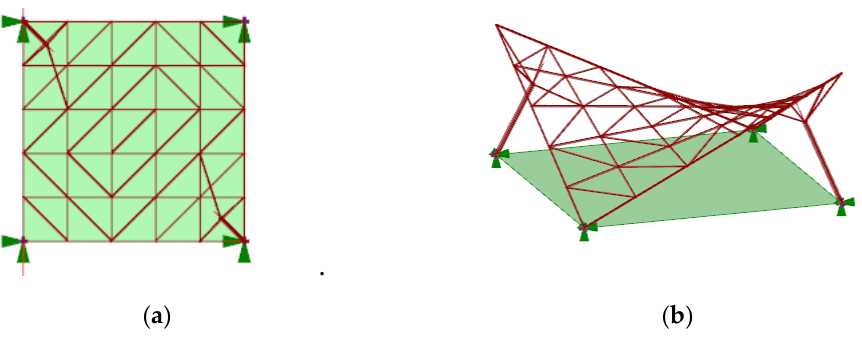
Figure 9. The structure of type a with the division of the grid pattern into five units: ( a ) an orthogonal projection; ( b ) an axonometric view of the structure.